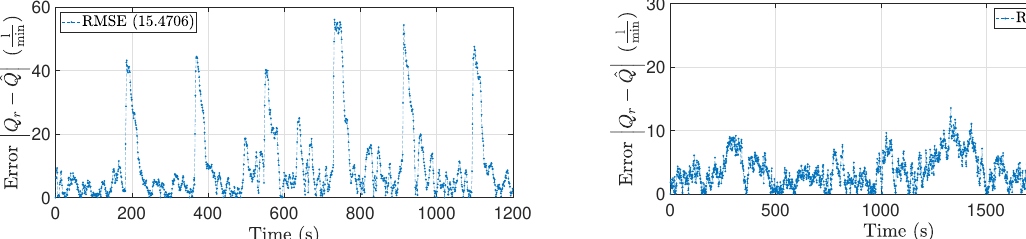
Figure 17: The absolute error between the reference Q r and estimated ˆ Q flow rates for non- Newtonian drilling